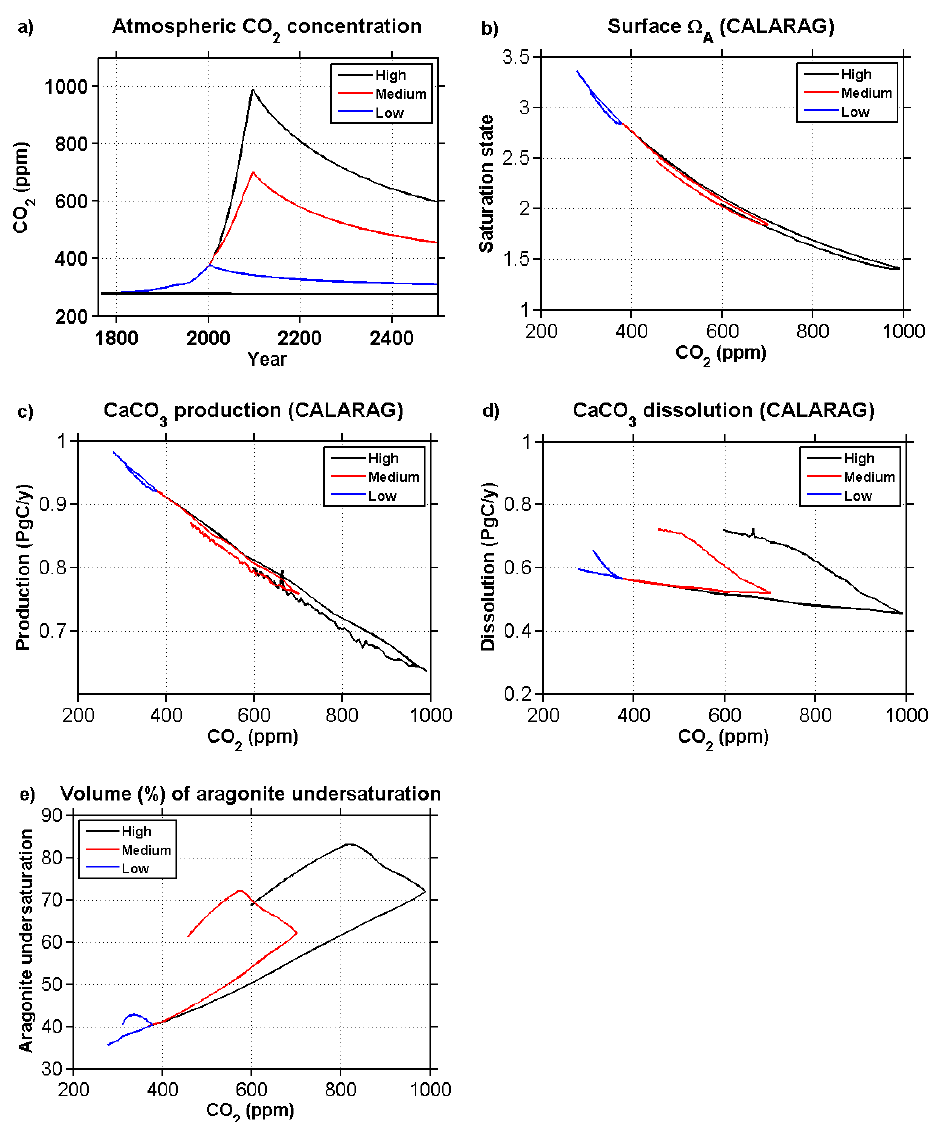
Fig. 16. Projected global mean values for a High, Medium, and Low emission scenario and for the Bern3D/PISCES version that includes aragonite and calcite production (CALARAG). Evolution of (a) atmospheric CO 2 as a function of time, (b) aragonite saturation state, (c) total CaCO 3 production, (d) open water CaCO 3 dissolution and (e) volume of aragonite undersaturation are shown as functions of atmospheric CO 2